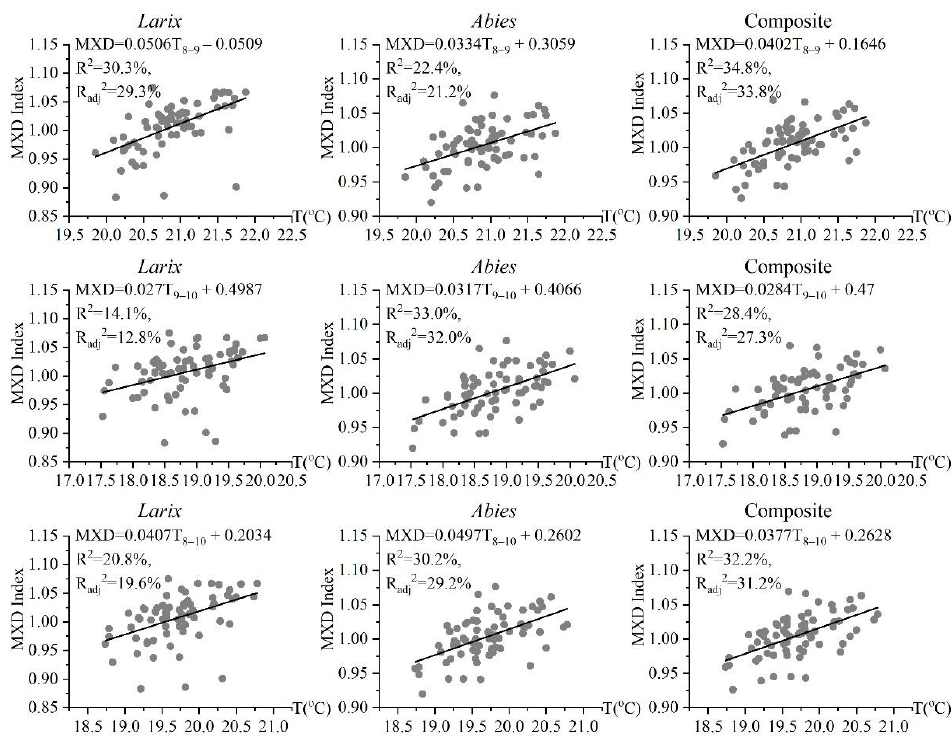
Figure 5. Linear regression between RES of MXD and late-summer temperature (CRU, 1951 – 2019). T 8 – 9 : mean temperature of August – September, T 9 – 10 : mean temperature of September – October, and T 8 – 10 : mean temperature of August – October.